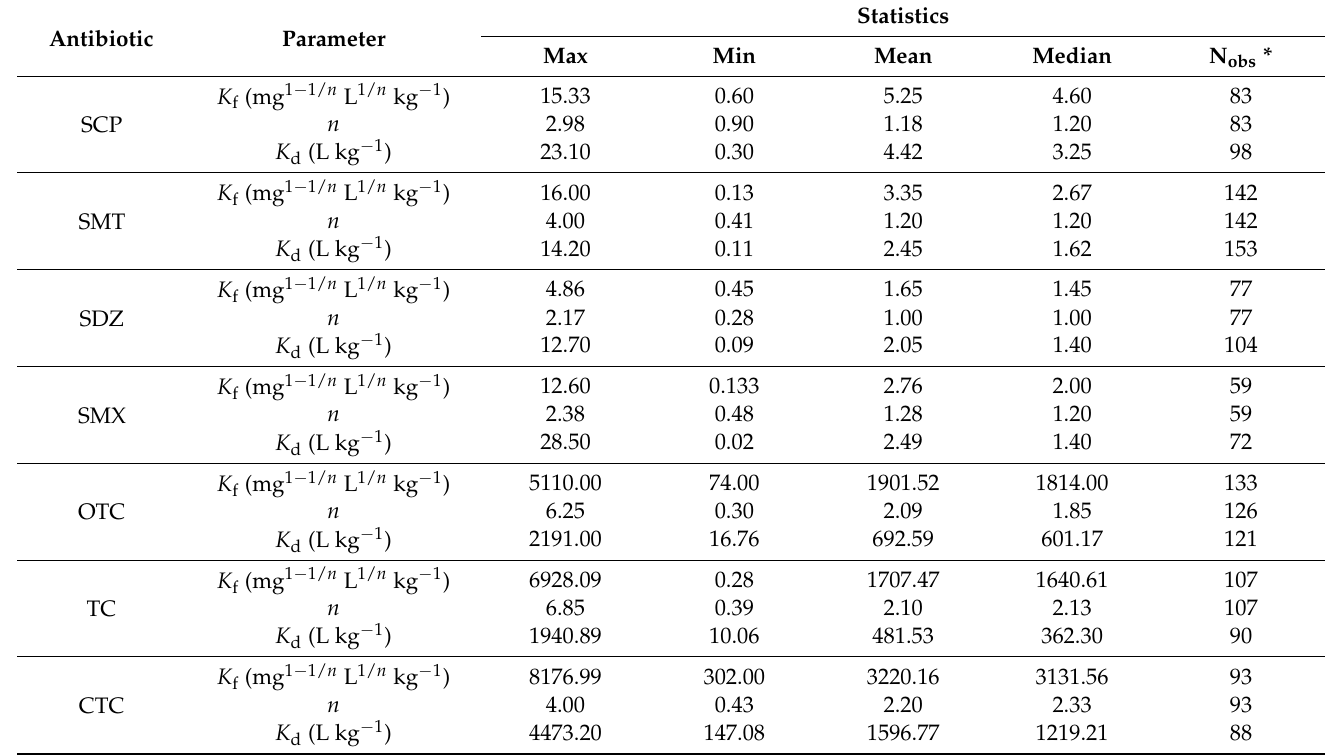
Table 2. Statistical characteristics of sorption parameters of individual antibiotics in the